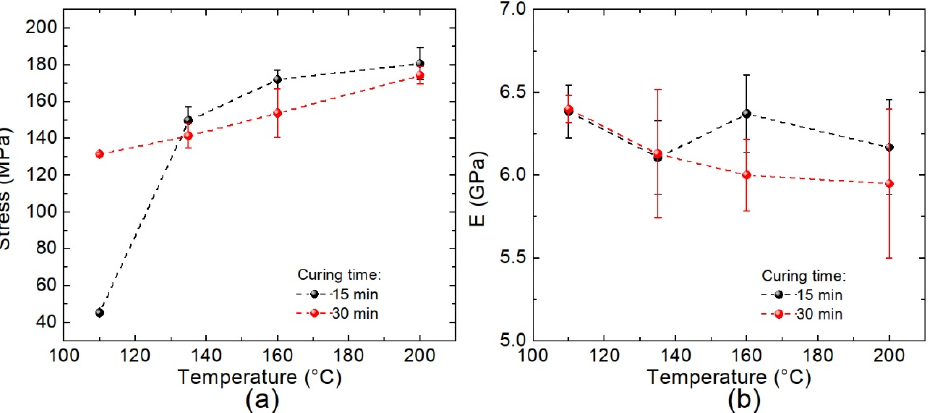
Figure 14. ( a ) Ultimate tensile strength; ( b ) Young’s modulus for [±45°] WCFF/Aerotuf composite laminates manufactured at several curing temperatures and two molding times.